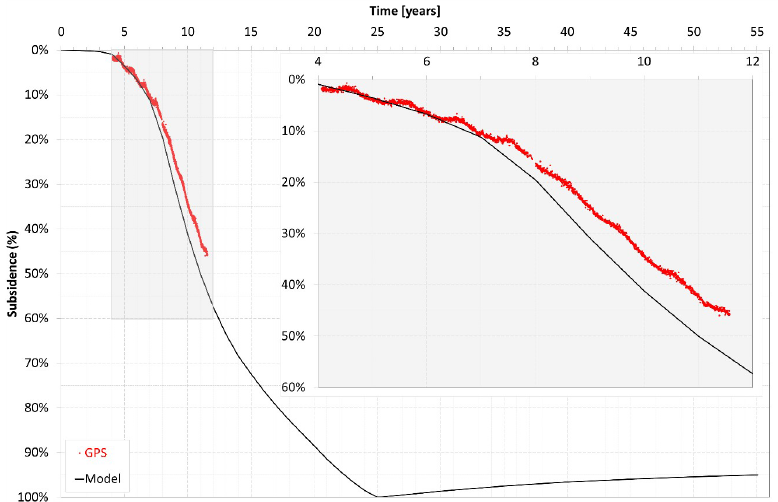
Figure 5. Time evolution of subsidence at platform A: GPS data versus model estimate, with magnification.